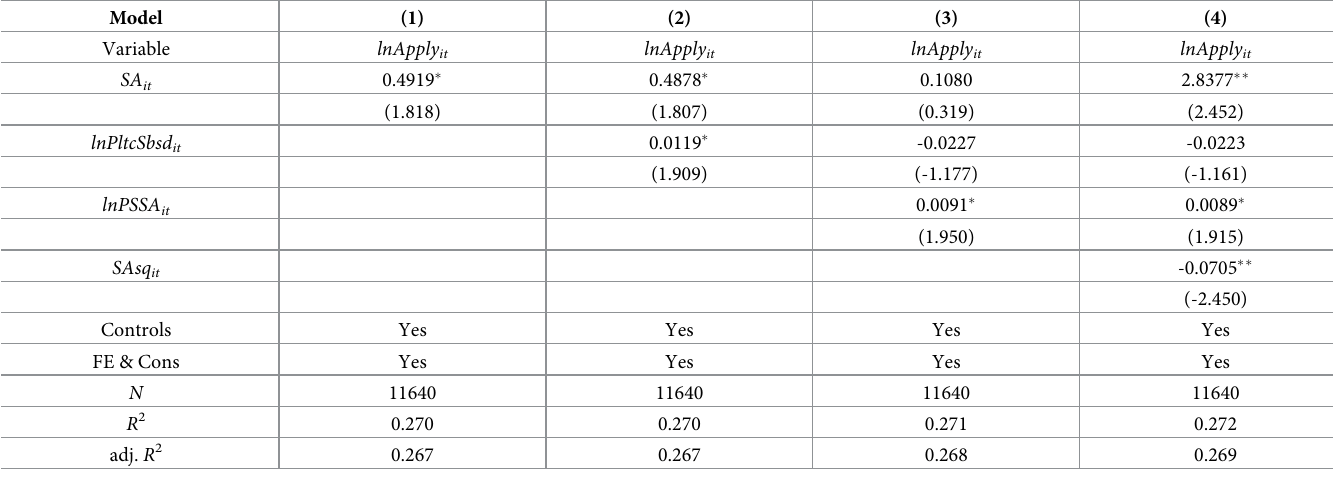
Table 4. Main results of moderating